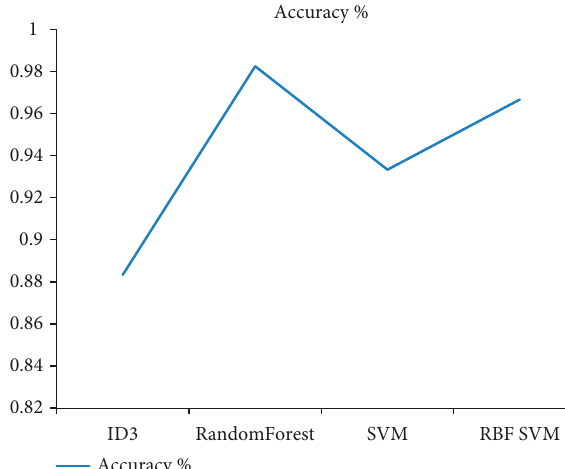
Figure 4: Sensitivity results of Machine Learning